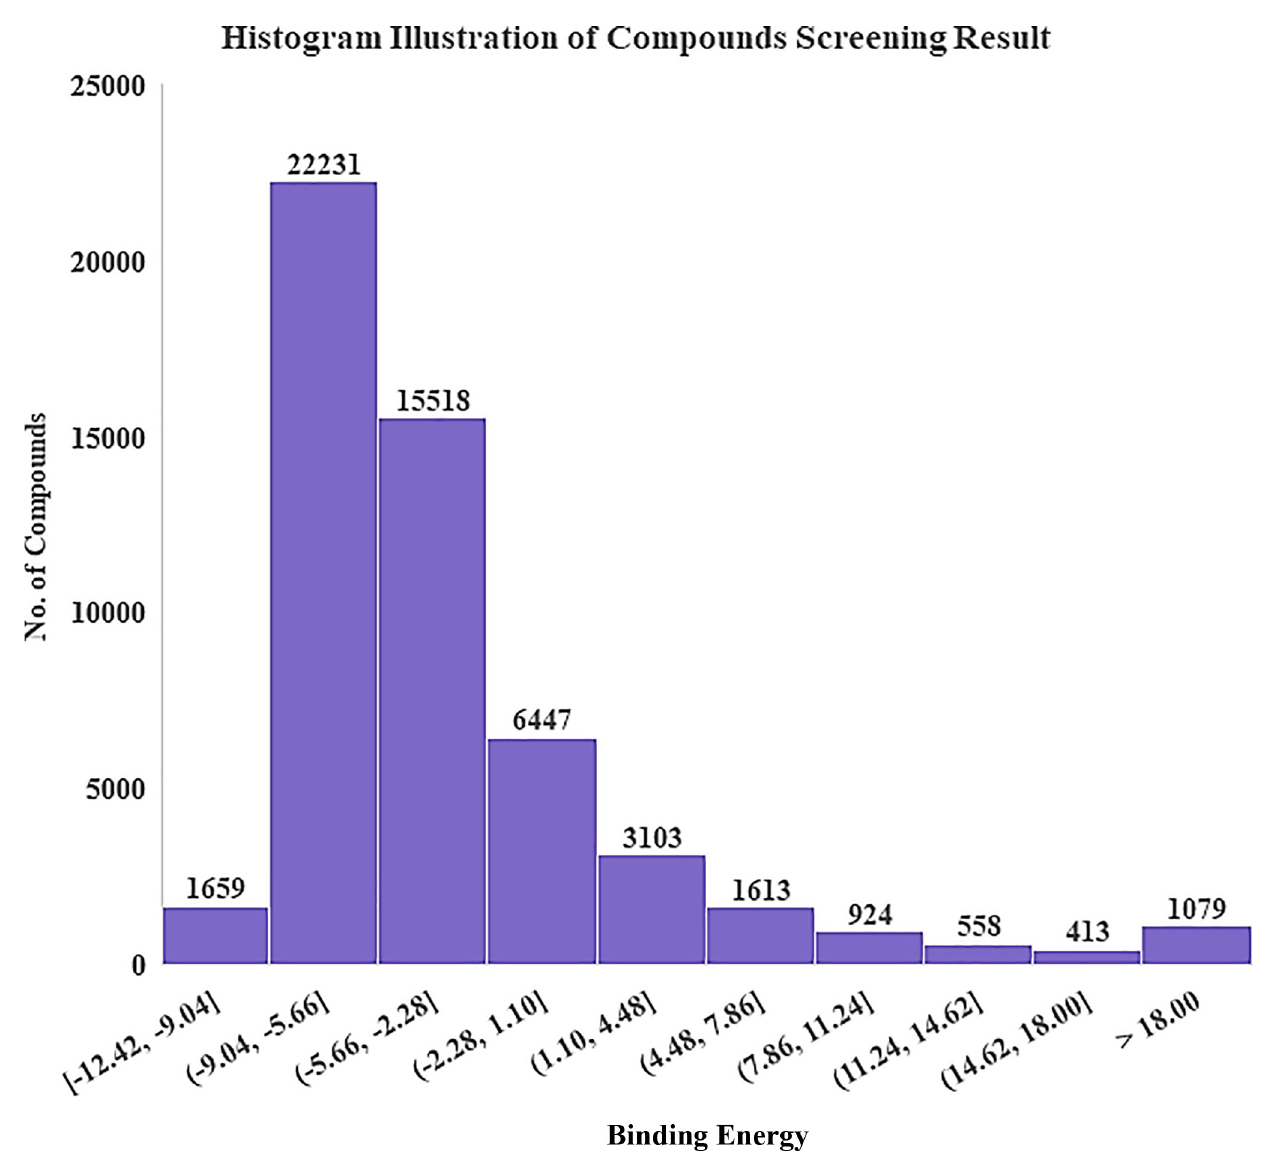
Fig 3. Histogram illustration of the overall binding energy retrieved through virtual